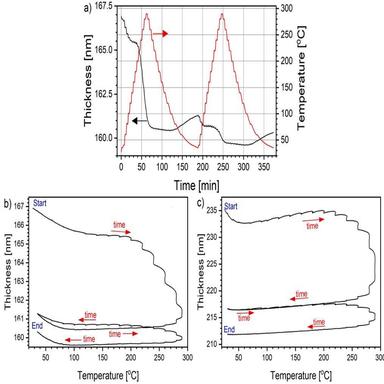
a) Example of a TEOS_sw heated/cooled in a step-wise manner. The plot referenced to the right scale represents temporal dependence of the temperature while the other corresponds to the thickness changes. Thickness/Temperature dependence obtained for b) TEOS_sw, c) TEOS_BTSE_sw.